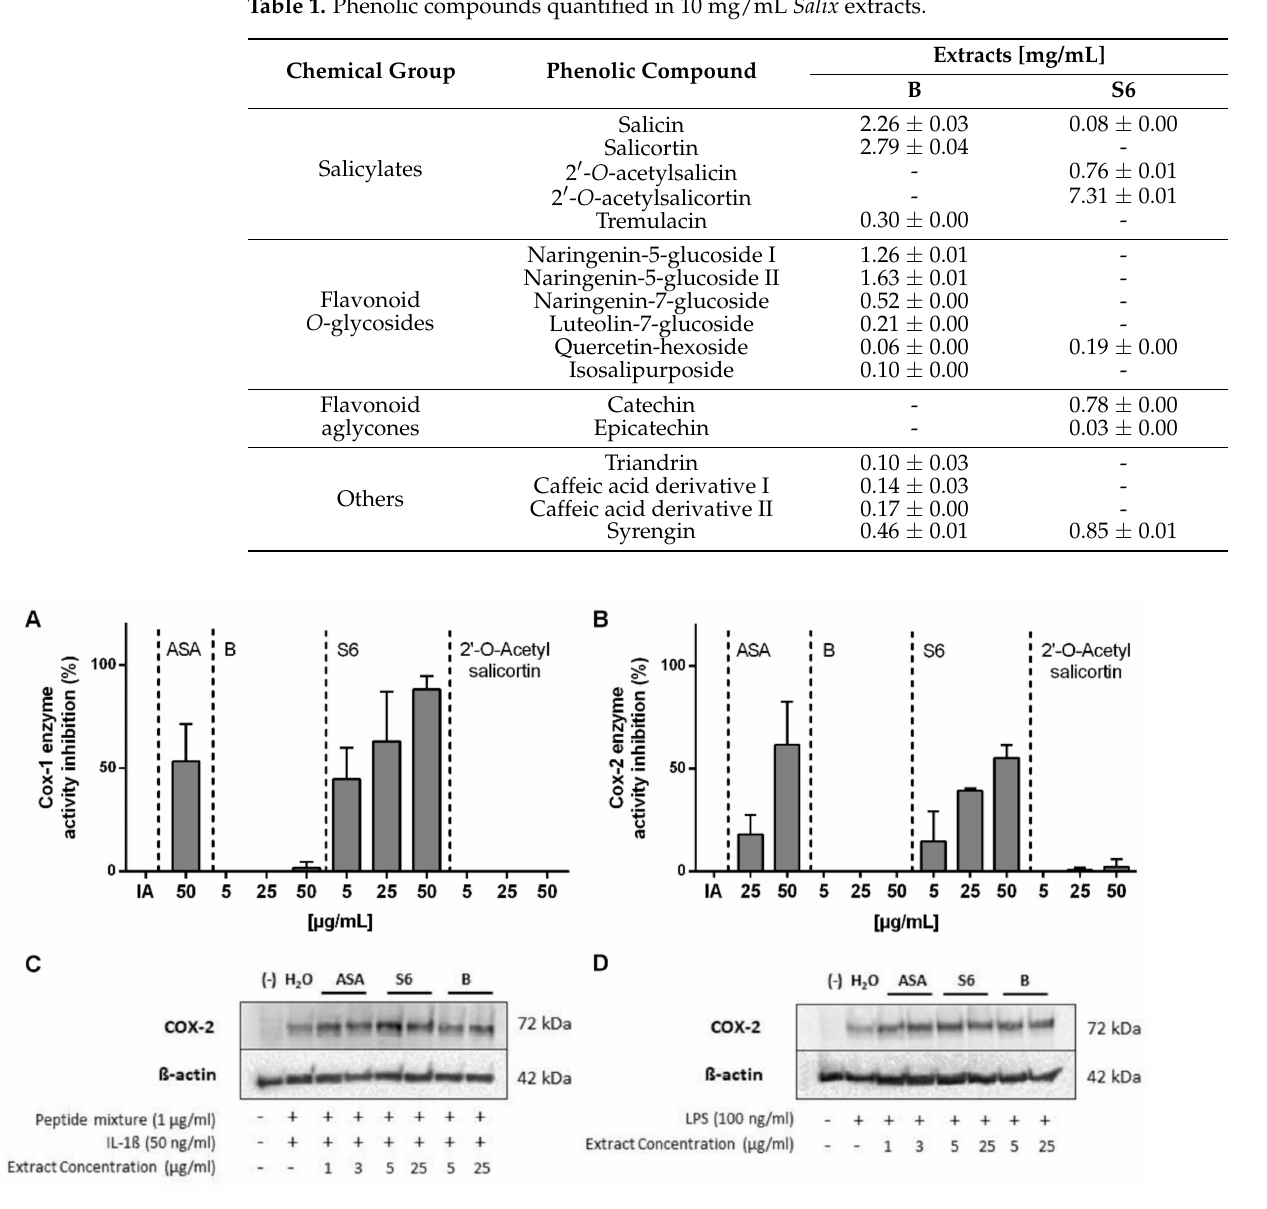
Figure 2. The effects of Salix extracts and ASA on COX1/2 enzyme activity. Human recombinant ( A ) COX-1 or ( B ) COX-2 enzyme activity was quantified by detection of prostaglandin PGF 2 α production using the ELISA technique. The inhibition (%) was calculated by comparison to the Initial Activity (IA) of the respective COX enzyme. Bars are the means ± SD ( n ≥ 3). Western blot of COX-2 protein expression. PBMCs (1 × 10 6 cells/mL) were pre-treated with Salix extracts or ASA for 30 min and subsequently stimulated with ( C ) 1 µ g/mL peptide mixture and 50 ng/mL IL-1 β or ( D ) 100 ng/mL LPS for another 3 h. Cells were lysed, and the total lysate was subjected to western blotting. Representative immunoblots of COX-2 and β -actin (loading control) are